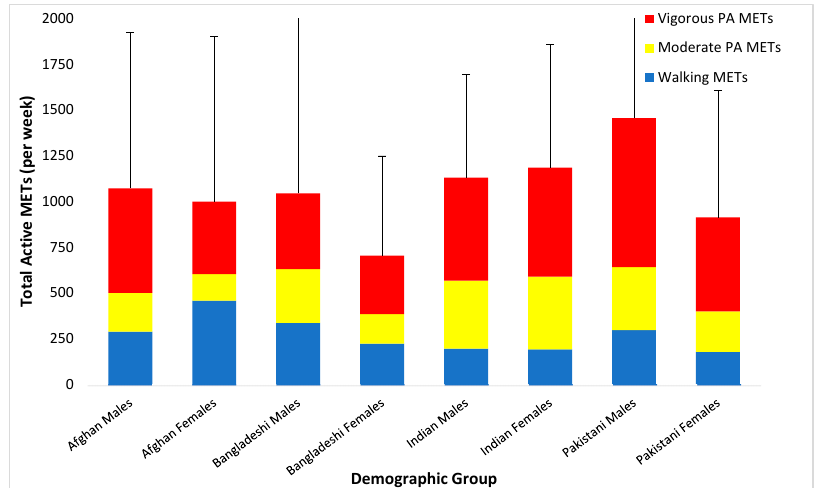
Figure 2. Total active METs per week of males and females across the four ethnic groups.